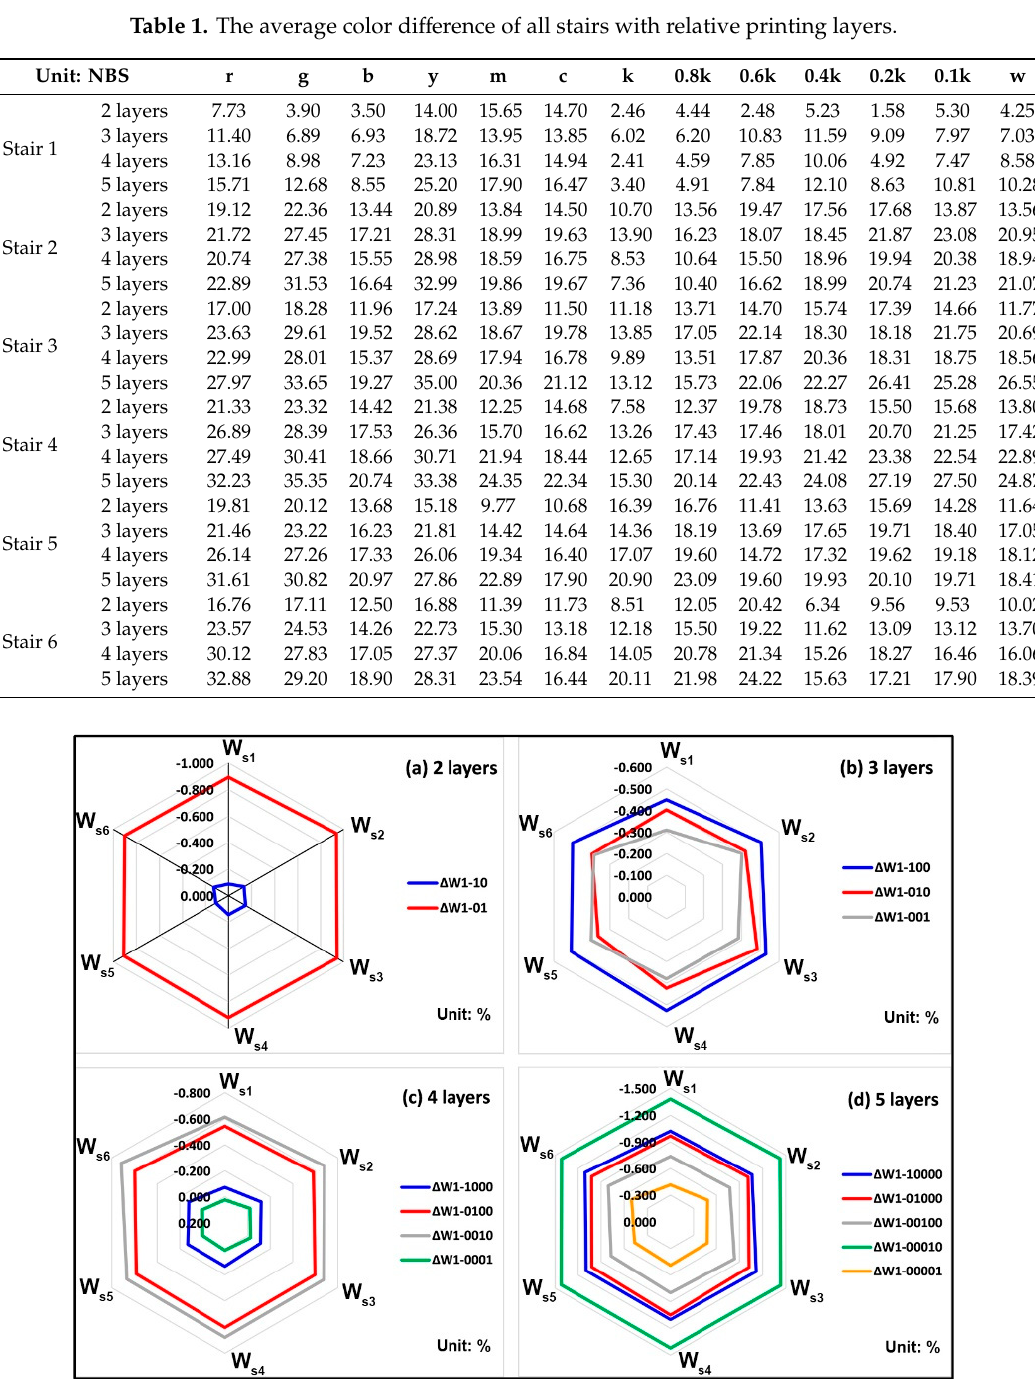
Figure 1. Whiteness changes between six white blocks with specific printed layers and blocks with one single layer (sample ID 1): ( a ) 2 layers; ( b ) 3 layers; ( c ) 4 layers; ( d ) 5 layers. Table 1. The average color difference of all stairs with relative printing layers.